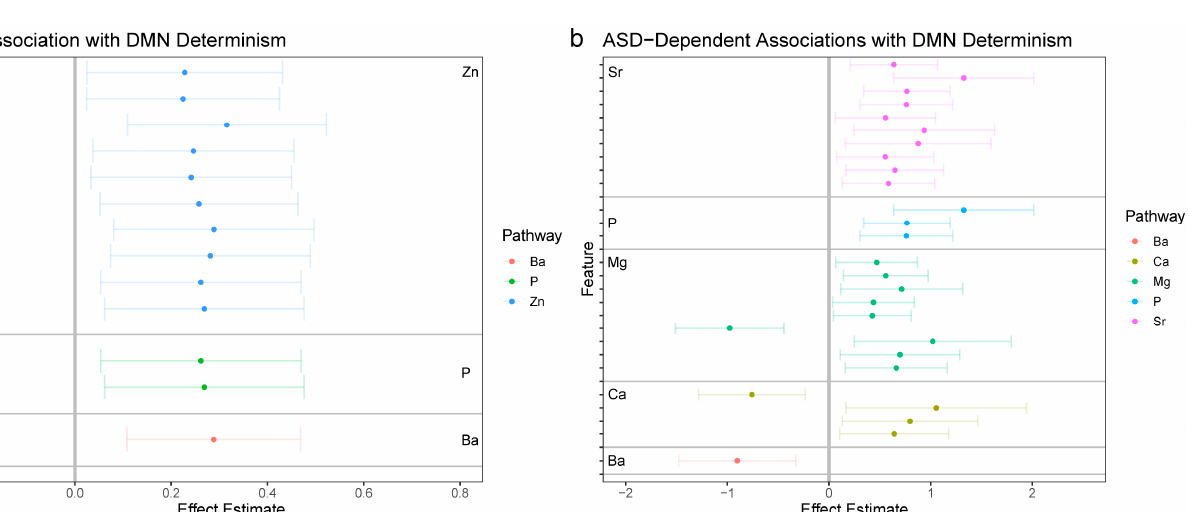
Figure 3. Associations between elemental dynamics and right lateral parietal lobe. ( a ) Left panel shows effect estimates for associations between elemental features and determinism in the right lateral parietal lobe BOLD signal; only features with significant associations following FDR-adjust- ment for multiple comparisons are shown. ( b ) Right panel shows effect estimates for the interaction between autism and features of elemental dynamics; features with significant associations following FDR-adjustment for multiple comparisons are shown. The magnitude of effect estimates in essence depicts the difference in a given feature between participants with autism and control participants. 3.2.3. MPFC: LP R Synchronization In Figure 4a (left panel), we highlight associations between features of elemental dy- namics and functional connectivity between the medial prefrontal cortex (MPFC) and the right lateral parietal (LP R ), as measured in Curtin et al. [8] via the quantification of CRQA determinism. As in the analysis of periodicity in the overall DMN, and within the LP R , specifically, we found again a pattern of positive associations involving multiple ele- ments, primarily dominated by zinc.